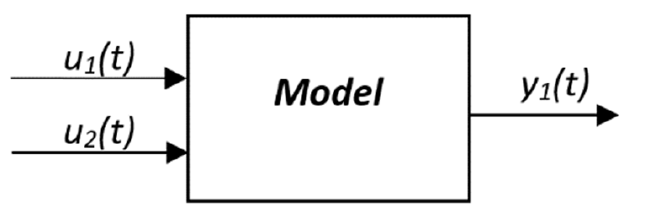
Figure 3. Diagram of the block structure of the process model. where: u 1 ( t )—degree of opening of the jig discharge slot (%); u 2 ( t )—linear speed of moving conveyor buckets (m/s); and y 1 ( t )–weight of the material on the conveyor (kg).